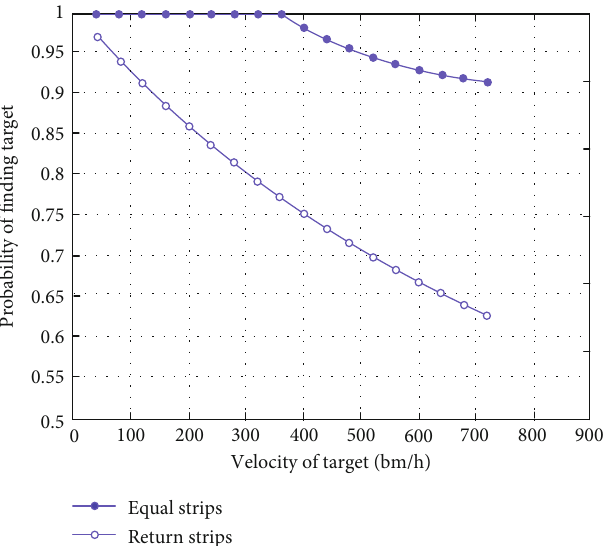
Figure 10: Probability of target discovery based-on di ff erent search